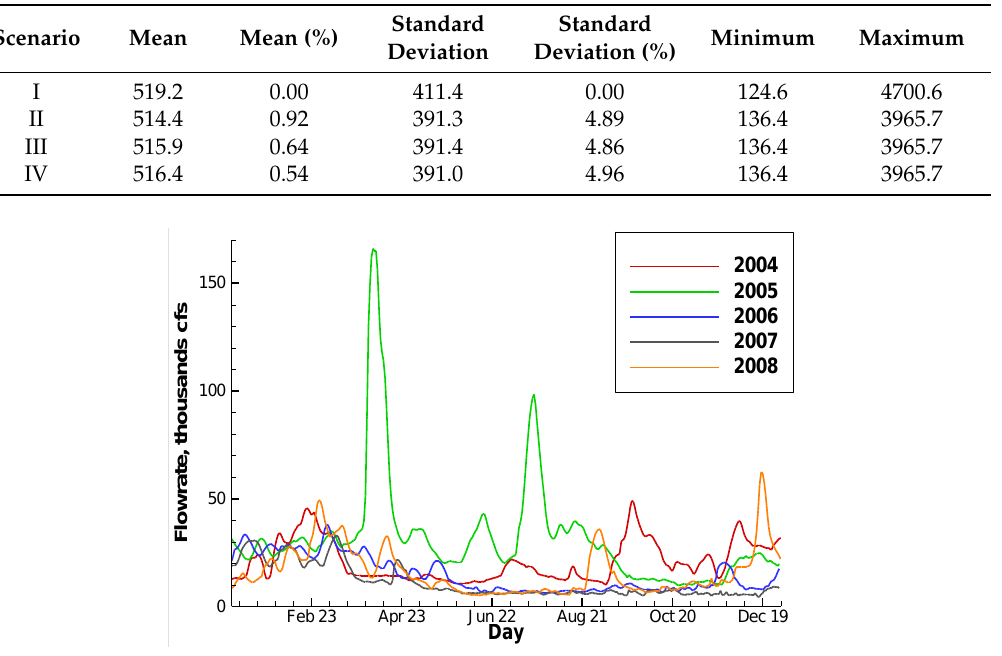
Table 1. Characteristics for the flow rates (cfs) at the Sumatra gage.